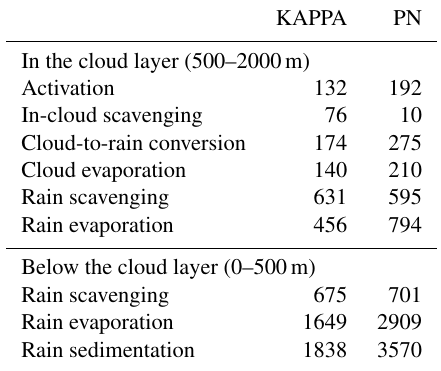
Table 5. Typical dry aerosol median radius (nm) associated with the microphysical processes for the KAPPA and PN